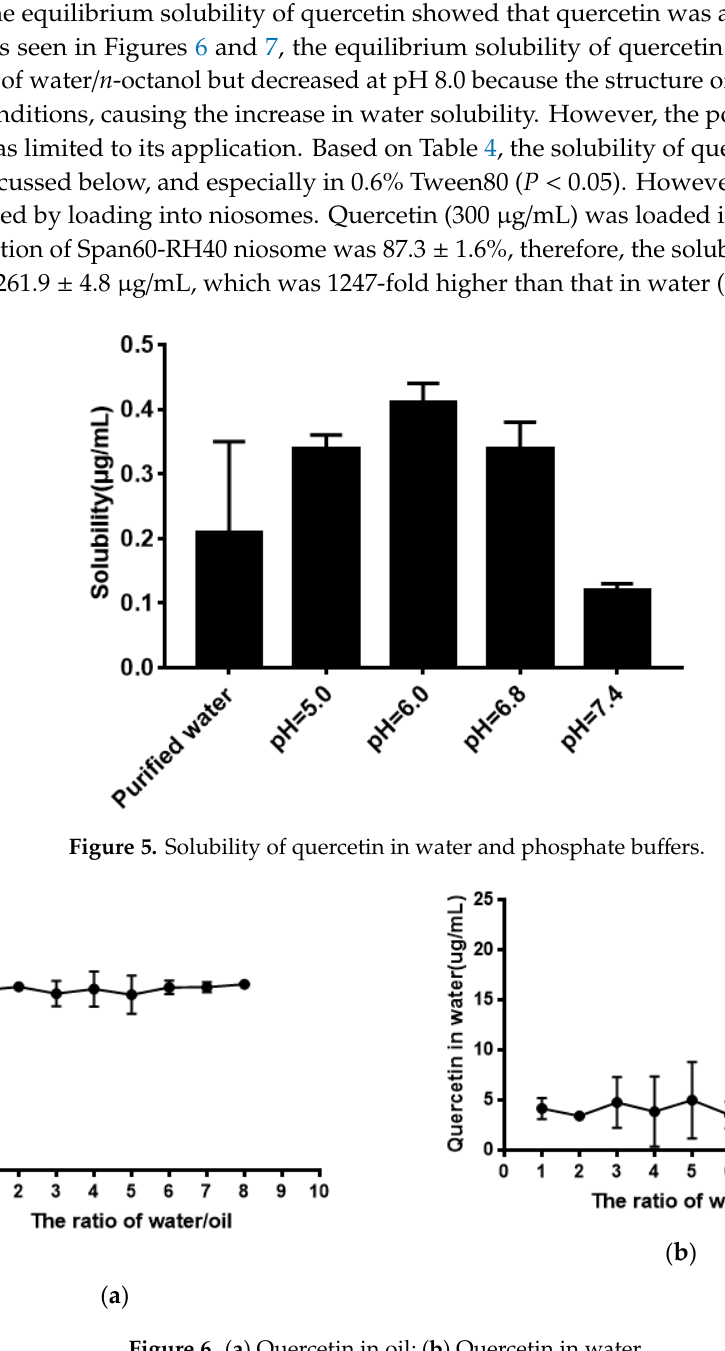
(b) Figure 7. ( a ) Quercetin in oil at different pH; ( b ) Quercetin in water at different pH. Table 4. Solubility of Quercetin in water, surfactants, and niosomes. Medium